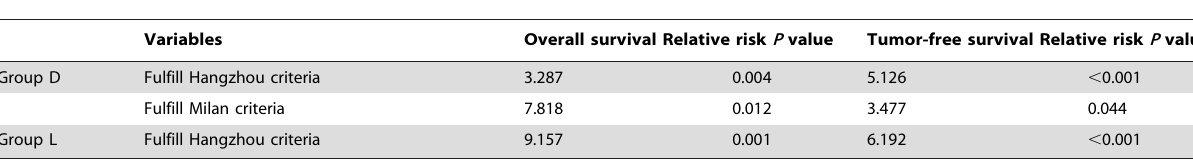
Table 3 . Independent variables in the Cox analysis for post-LT survival (Forward test).